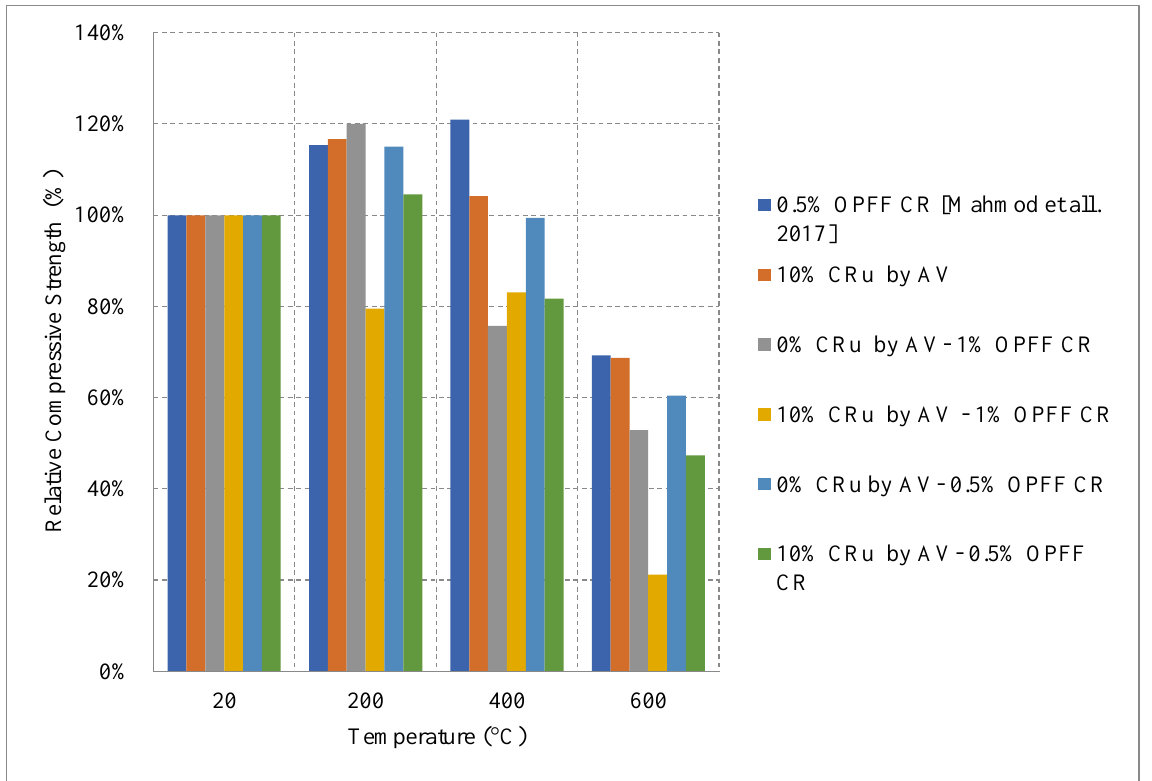
Figure 20. Effect of crumb rubber and palm fruit oil on the relative compressive strength of naturally cooled FRC. Cru: Crumb Rubber, OPFF: Palm Fruit Oil, CR: Cement Replacement, AV: Aggregate Volume [85].